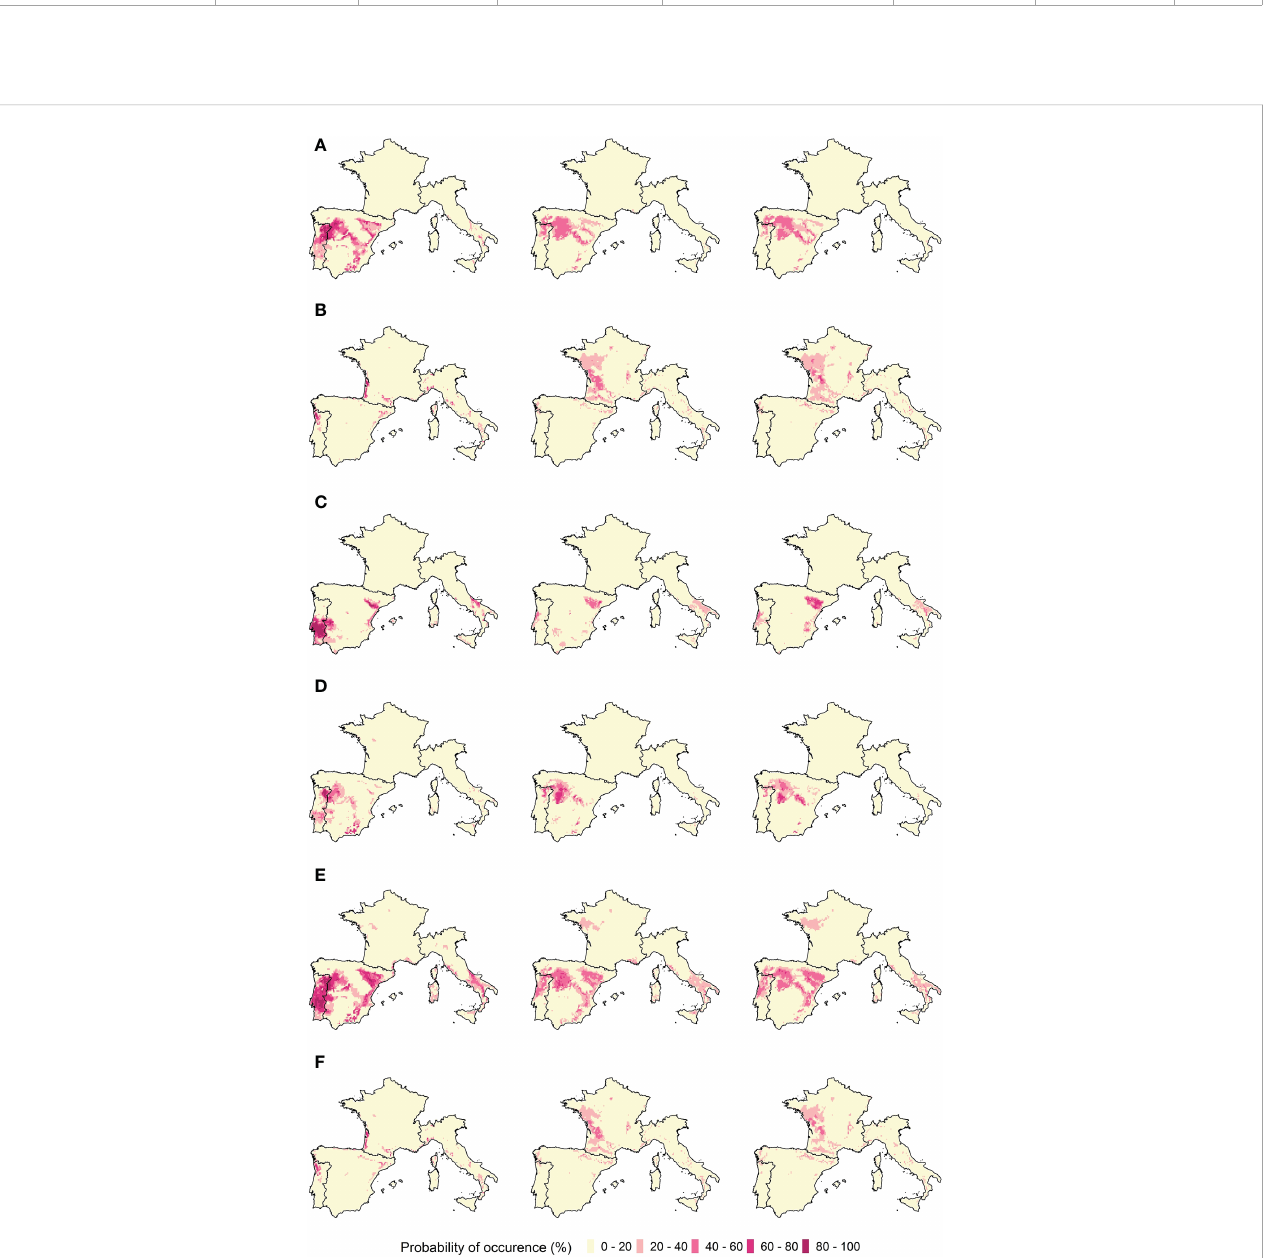
FIGURE 4 Ensemble model projected bioclimatic suitability for red varieties (A) Bastardo, (B) Borrac ̧ al, (C) Castelão, (D) Touriga-Franca, (E) Touriga-Nacional, and (F) Vinhão. Left panels: Recent past distribution of bioclimatic suitability (1989 – 2005). Middle panels: Future bioclimatic suitability projections (2021 – 2050), under the RCP 4.5 climatic scenario. Right panels: Future bioclimatic suitability projections (2021 – 2050), under the RCP 8.5 climatic